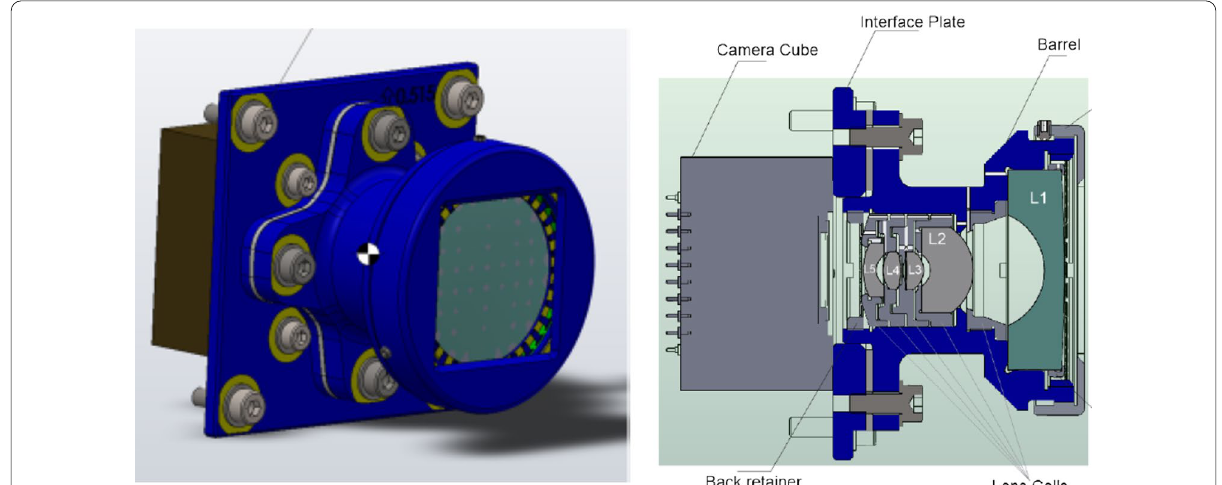
Fig. 6 The navigation cameras (NavCams). Left: CAD view; right: schematic